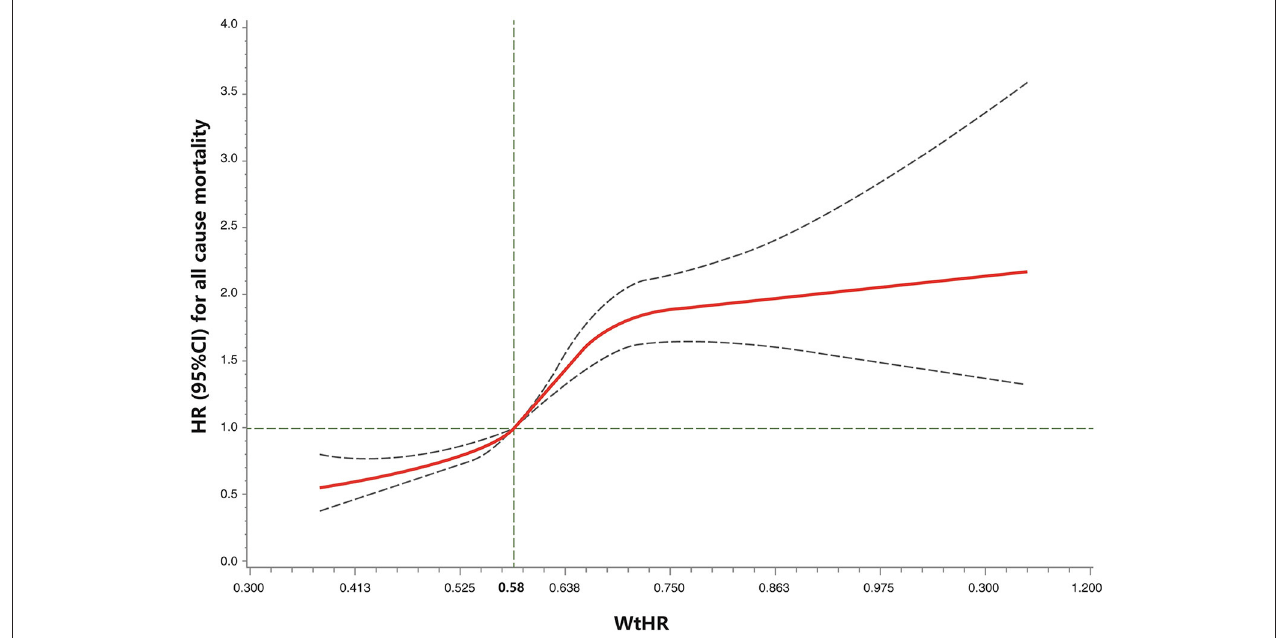
FIGURE 1 | Restricted cubic spline model of the association between the WtHR and all-cause mortality. Legend: Adjusted for demographics, lifestyle factors, body mass index, and chronic health conditions. The solid curve represents the HRs, and the dashed curves represent the 95% CIs. P overall < 0.01, P nonlinear < 0.01. WtHR, waist-to-height ratio.